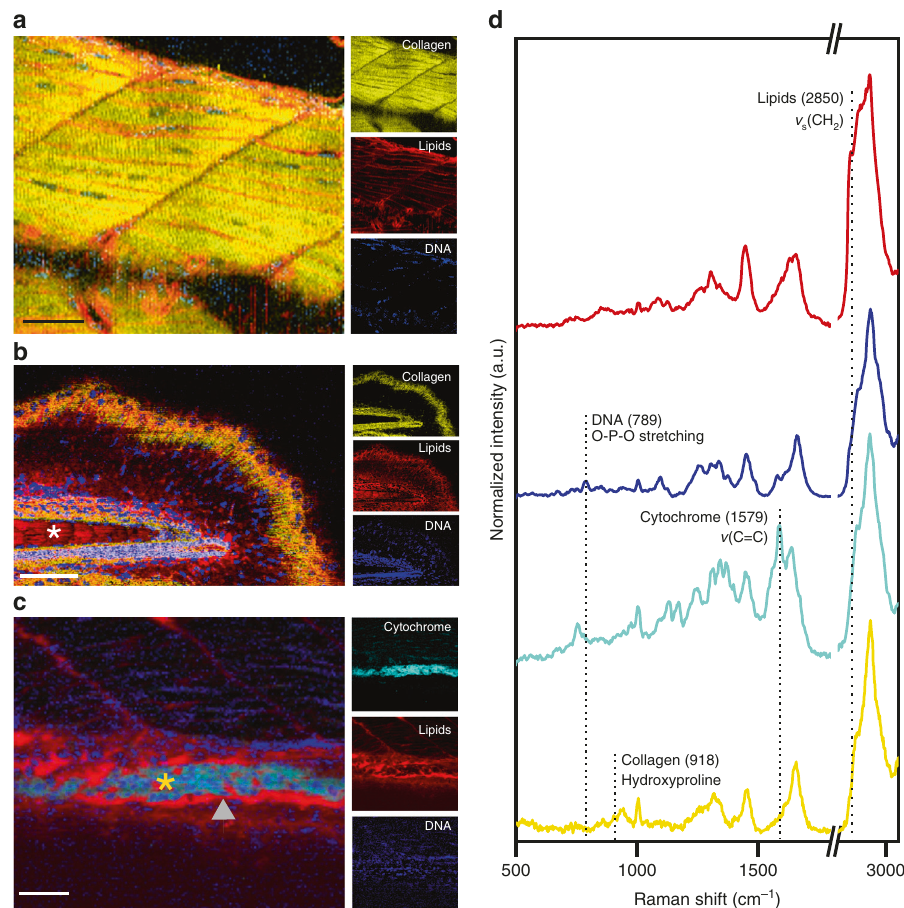
Fig. 3 High-resolution confocal Raman spectroscopic imaging for anatomical tissue characterization. Confocal Raman spectroscopic imaging (cRSI) was used to image tissue regions of interest at 3 days post fertilization, with a spatial resolution of 0.5 – 1 µ m. Univariate analysis was performed by integrating over a wavenumber range corresponding to relevant biomolecules: collagen-rich regions at 918 ± 20 cm − 1 (shown in yellow), DNA-rich regions at 789 ± 10 cm − 1 (shown in blue), lipid-rich regions at 2850 ± 10 cm − 1 (shown in red), cytochrome-rich regions at 1579 ± 15 cm − 1 (shown in cyan). a A representative image of the dorsal muscle tissue, from three independent cRSI scans ( N = 3). Scale bar: 40 µ m. b An exemplar scan of the tail tissue of a single embryo ( N = 1), with the white asterisk indicating the notochord. Scale bar: 50 µ m. c An exemplar scan of the developing gut of a single embryo ( N = 1), with the orange asterisk marking the gut lumen and the grey triangle points indicating the gut lining. Scale bar: 40 µ m. d Exemplar Raman spectra obtained from regions of intense univariate signal, with the labeled peaks used for univariate